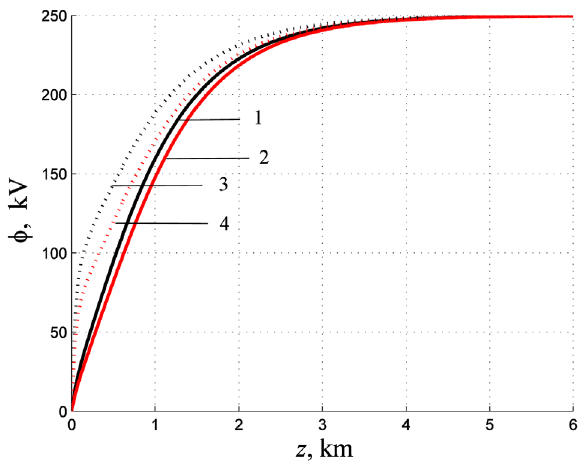
Figure 3. The same as in Figure 1 but for the atmospheric